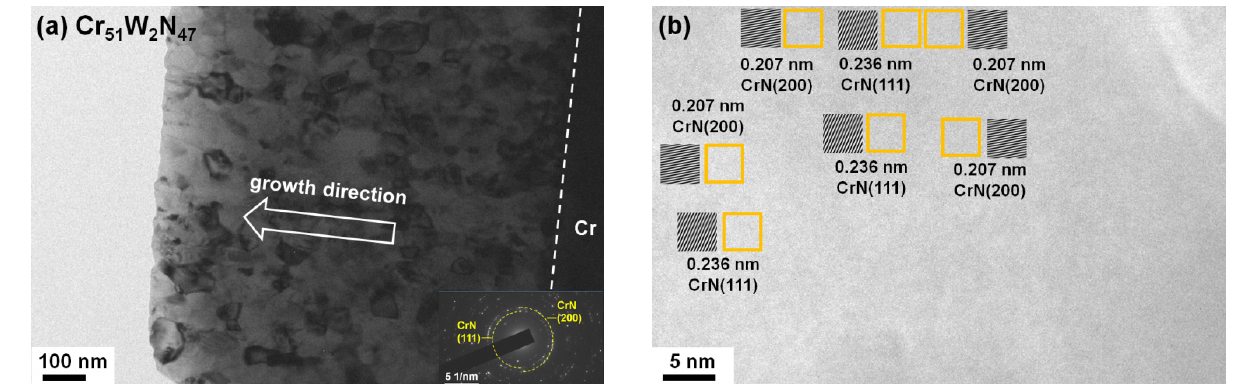
Figure 2. Cross-sectional FE-SEM images of ( a ) Cr 65 W 4 N 31 , ( b ) Cr 62 W 3 N 35 , ( c ) Cr 58 W 2 N 40 , and ( d ) Cr 51 W 2 N 47 coatings.